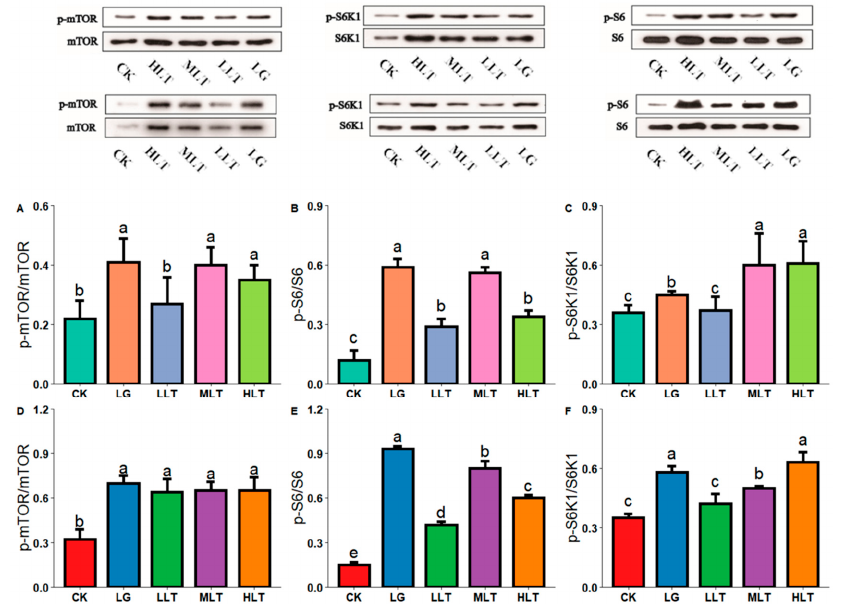
Figure 5. Effects of L-theanine on the phosphorylation status of proteins of mTOR, S6K1, and S6 in the jejunum ( A – C ) and duodenum ( D – F ) of mice. CK (control), HLT (LTA—400 mg•kg − 1 •d − 1 ), MLT 400 mg • kg − 1 • d − 1 ), MLT (LTA—300 mg • kg − 1 • d − 1 ), LLT (LTA—100 mg • kg − 1 • d − 1 ), and LG (L- glutamine—300 mg • kg − 1 • d − 1 ) groups. Values are presented as mean ± SD; n = 3/group. Different superscript letters in the same figure indicate statistically significant differences ( p <